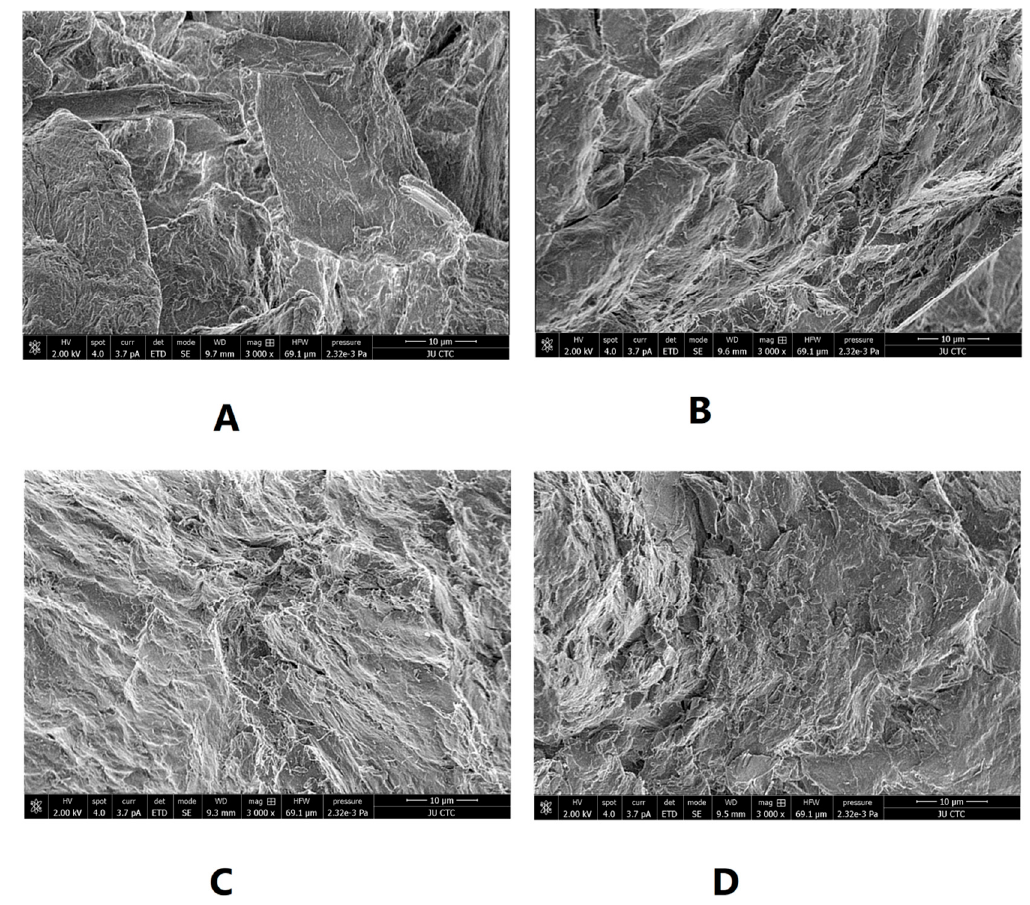
Figure 5. SEM of non-compacted Avicel PH-101 101 ( A ), roller compacted Avicel-1st compaction cycle ( B ), roller compacted Avicel-2nd compaction cycle ( C ), and roller compacted Avicel-3rd compaction cycle ( D ) at magnification of 3000×.